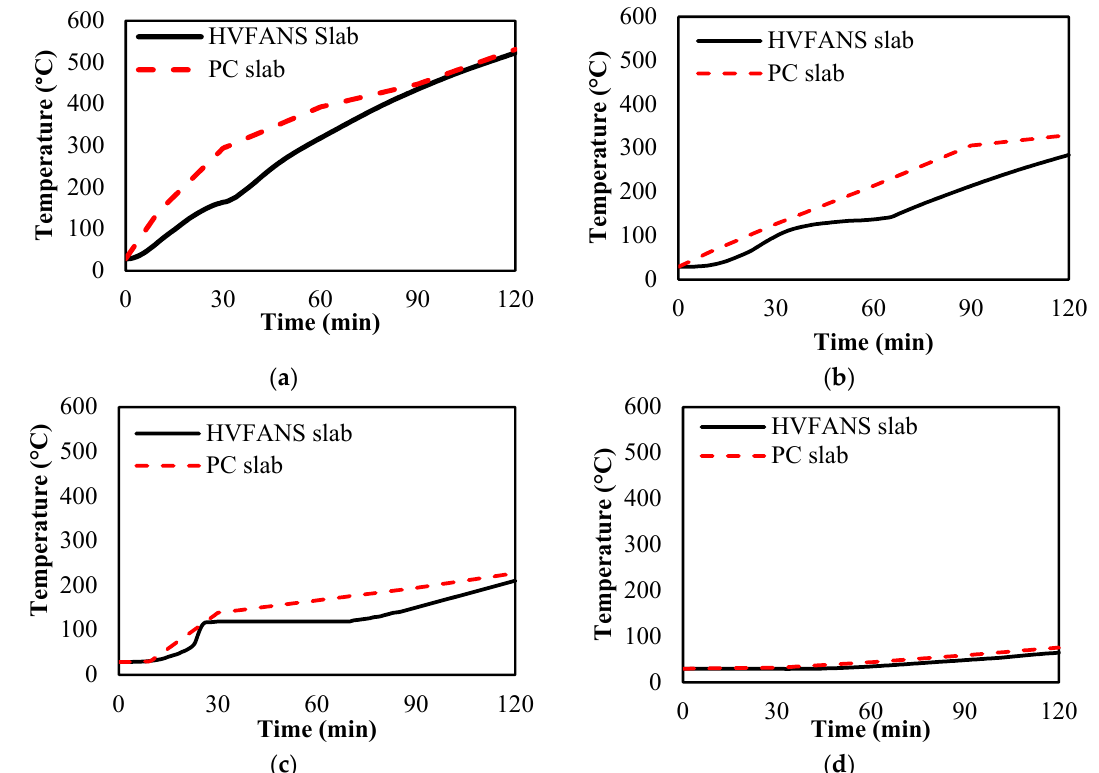
Figure 4. Temperature distribution of PC and HVFANS slabs at depths: ( a ) 30 mm; ( b ) 60 mm; ( c ) 90 mm; ( d ) 200 mm, from the exposed surface.